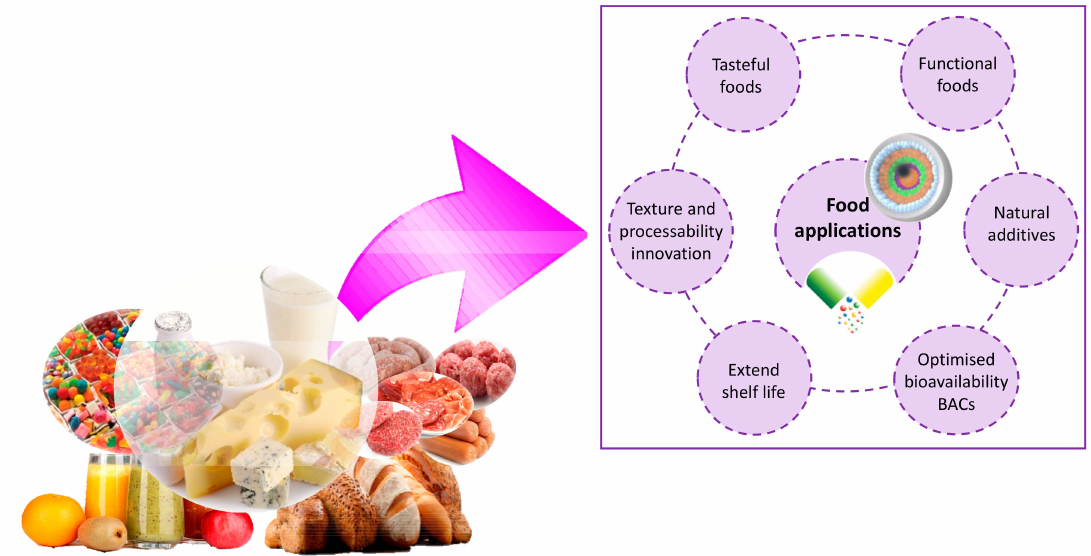
Figure 3. Improvement of stability, functionality and appearance of food products through nanoencapsulation of